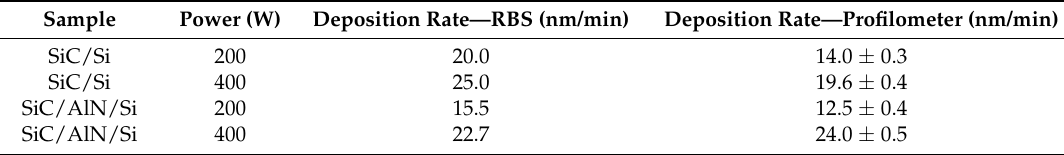
Table 2. Deposition rate of the SiC films.